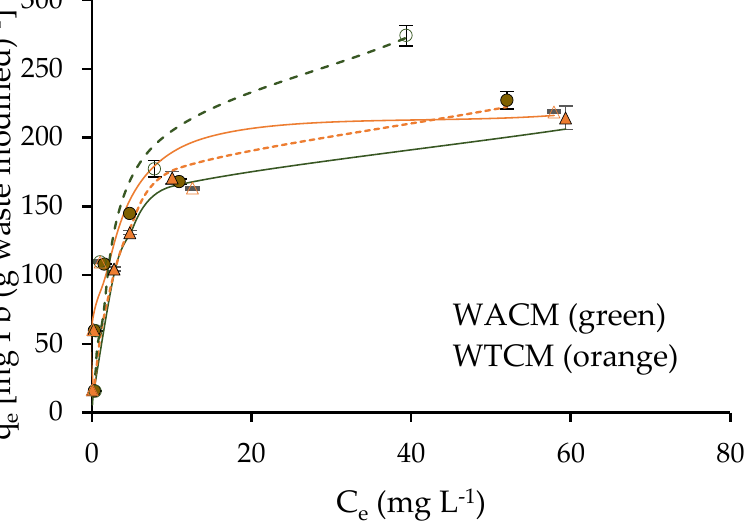
Figure 8. WACM and WTCM adsorption isotherms fitted to Langmuir model. For pH 4 (continuous lines) and pH 5 (dotted lines); biosorbent dose = 2 g L − 1 , t = 120 min, T = 293 K.